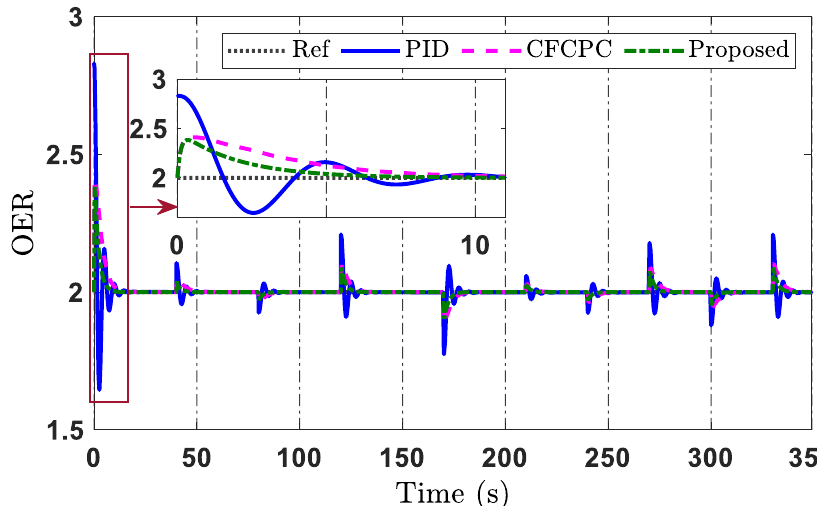
Figure 4. Performance comparison of the proposed and comparative controllers in the simulation.